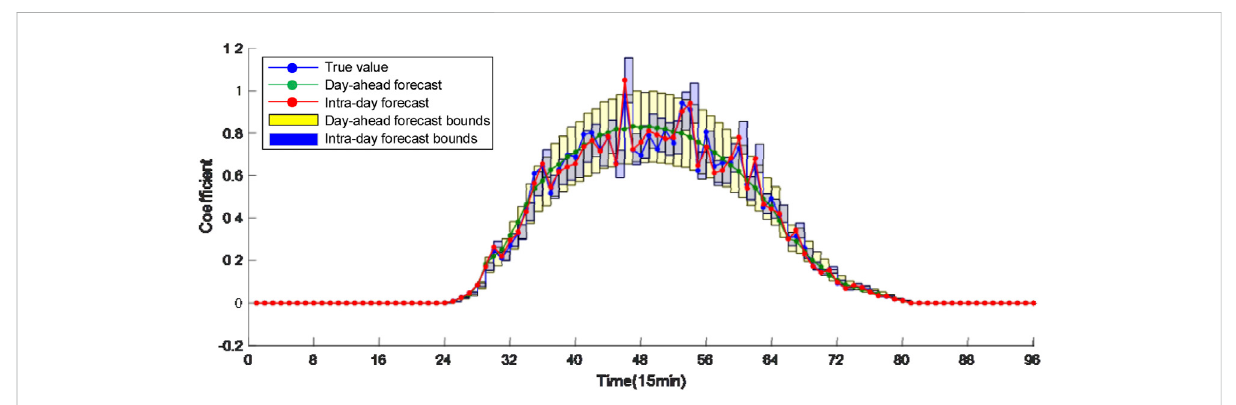
FIGURE 6 Day-ahead and intro-day forecasting curves of PV